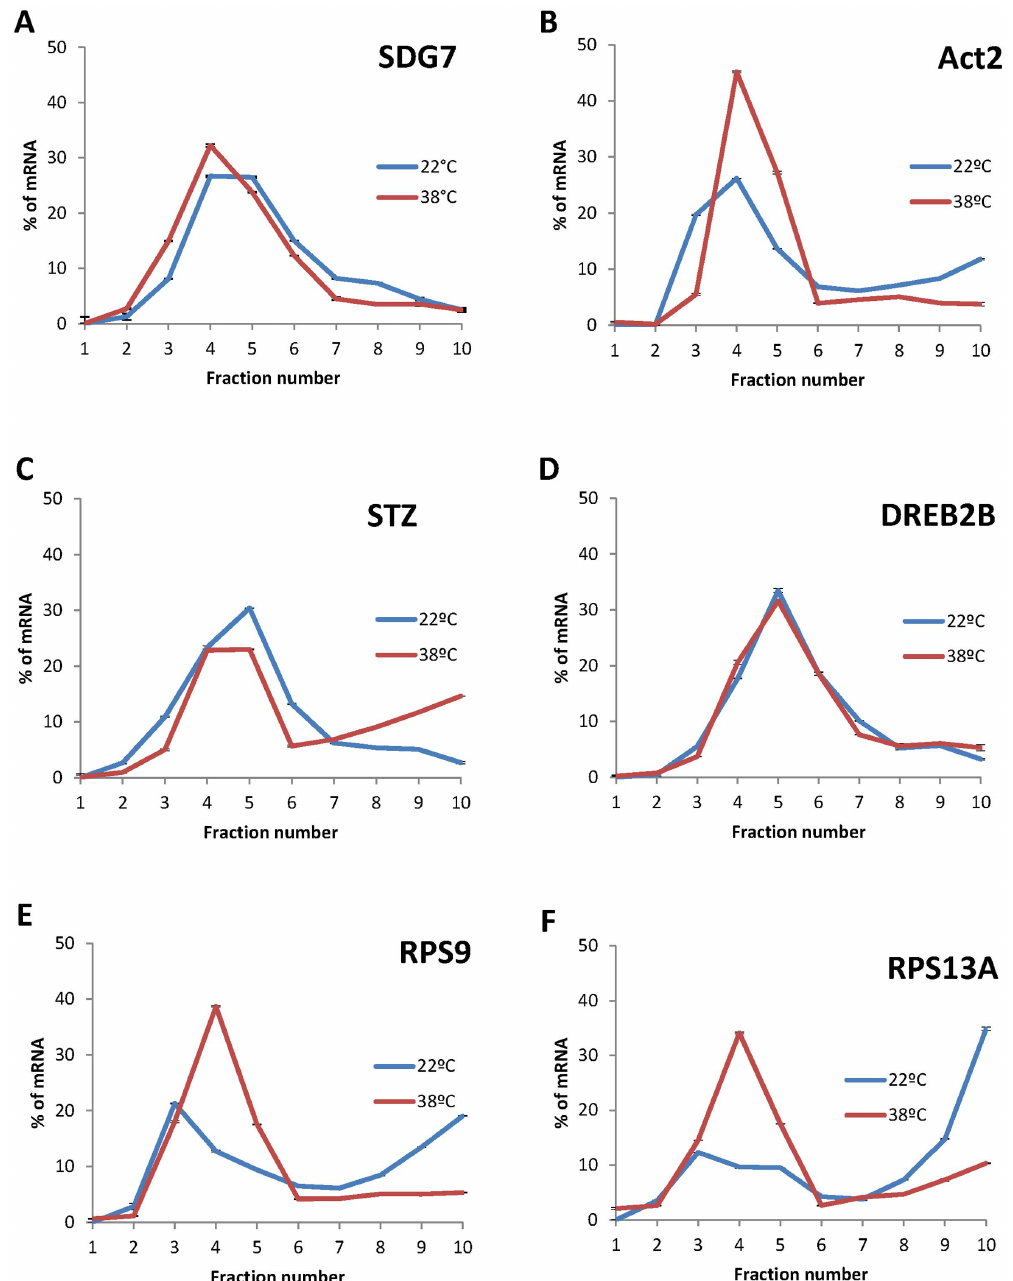
Figure 5. Heat-induced changes in polysome association for functionally relevant mRNAs. The distribution through the different fractions of a representative polysome gradient of the mRNAs coding for SDG7 ( A ), ACTIN2 ( B ), STZ/ZAT10 ( C ), DREB2B ( D ), the ribosomal protein S9 ( E ) and the 40 9 S ribosomal protein S13A ( F ) was analyzed by qRT-PCR, as specified in materials and methods. The percentage of the mRNA content within the different fractions at 22 u C and 38 u C are indicated in blue and red, respectively. Standard deviations were calculated from technical repeats.